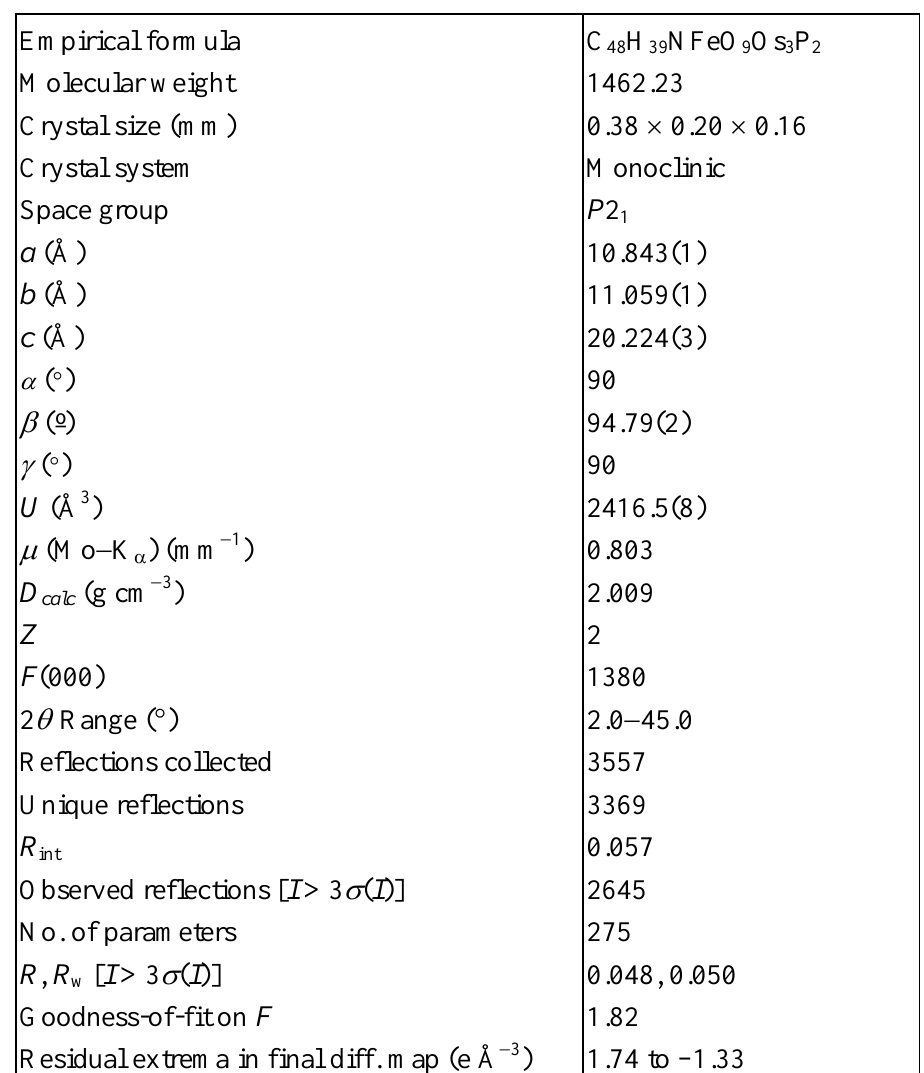
Table 2. Crystal data and structure refinement of 1